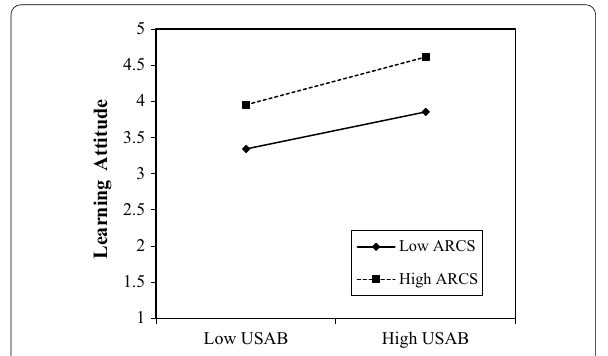
Table 7 Multi‑group analysis by PLS‑MGA method